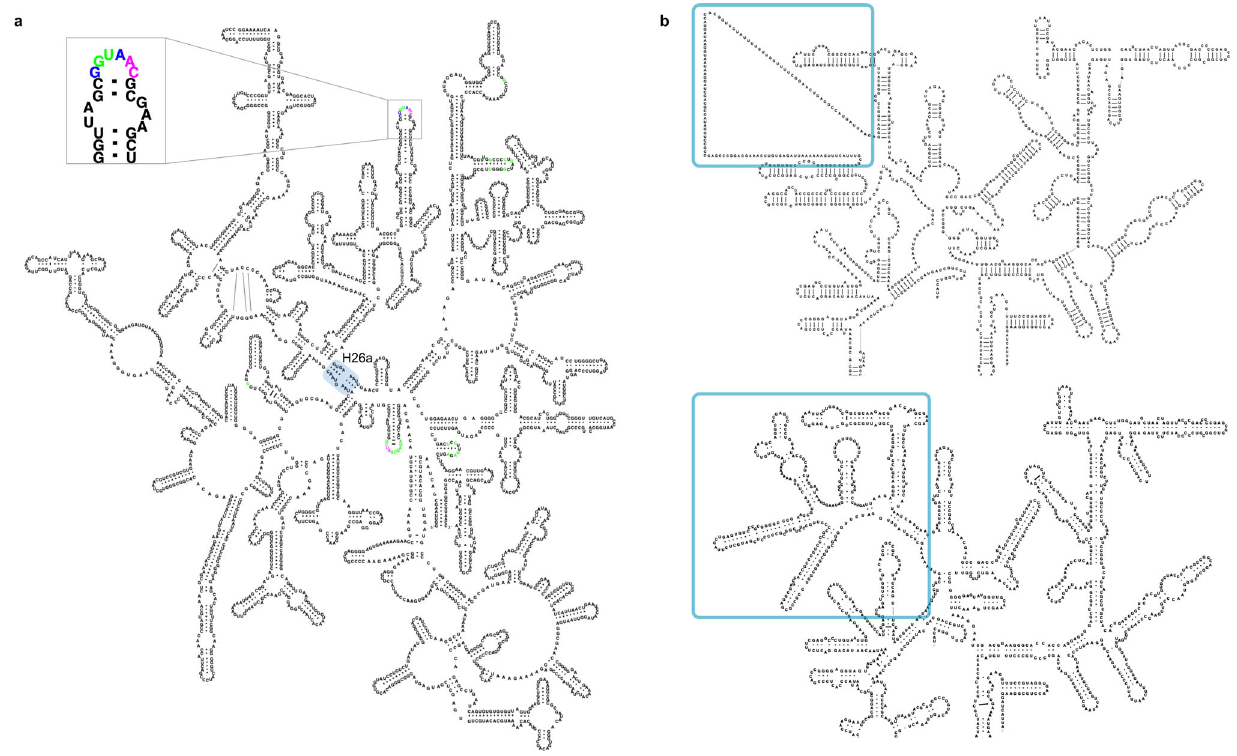
Fig. 3 Example of 3D structure-based rRNA templates. a An Escherichia coli LSU rRNA is displayed by R2DT using a single-page layout (URS0000051AF4_562). Helix 26a is highlighted with a blue box. An inset shows a zoomed-in fragment with nucleotides that are identical between the template and the sequence shown in black, insertions shown in magenta, and nucleotides that are different between the template and the sequence shown in green. b A fragment of a covariation-based human SSU rRNA layout based on the CRW template (top) and the revised, 3D structure-based template showing additional base-pairing interactions (bottom). The species-speci fi c region is highlighted in